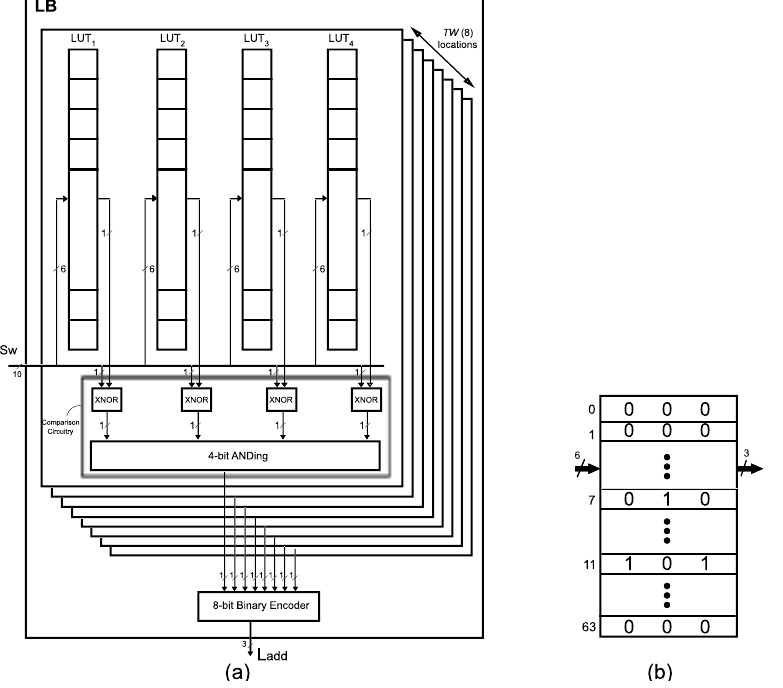
Figure 4. Two major blocks of Zi-CAM architecture. ( a ) Lookup table (LUT) block (LB) for 8 × 10 Zi-CAM having eight pages with four LUTs each. ( b ) RAM block (RB) for 8 × 10